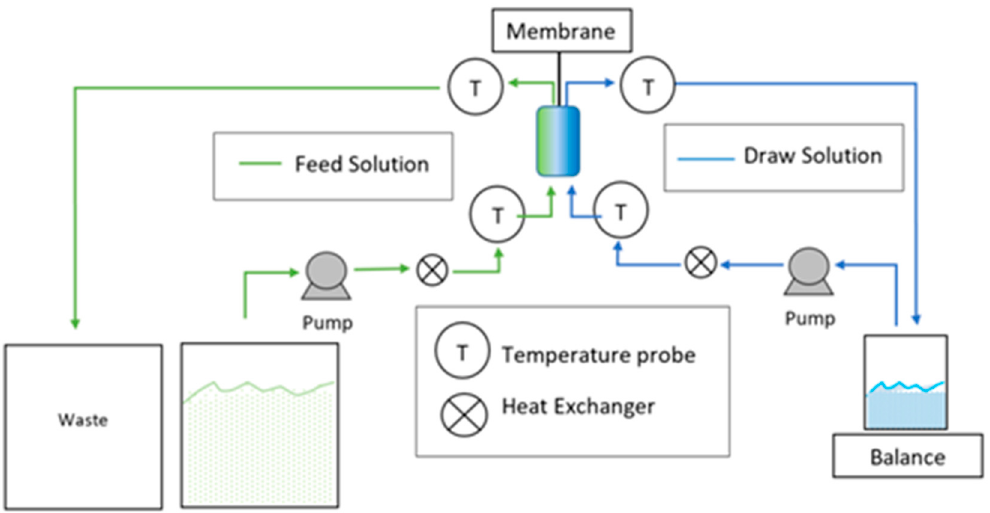
Figure 1. Forward osmosis bench top design. The draw solution (DS) is a closed-loop system while the feed solution (FS) is a single-pass design.